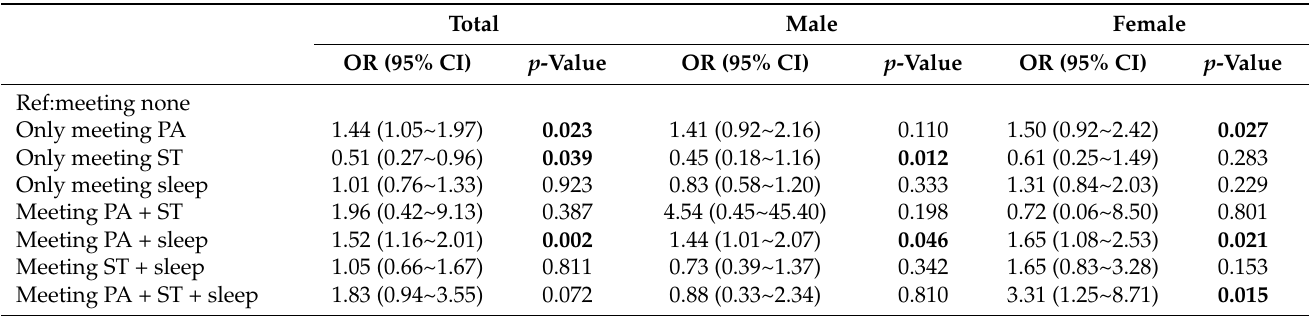
Table 4. The relationship between meeting 24-HMG categories and mental health in the sample.